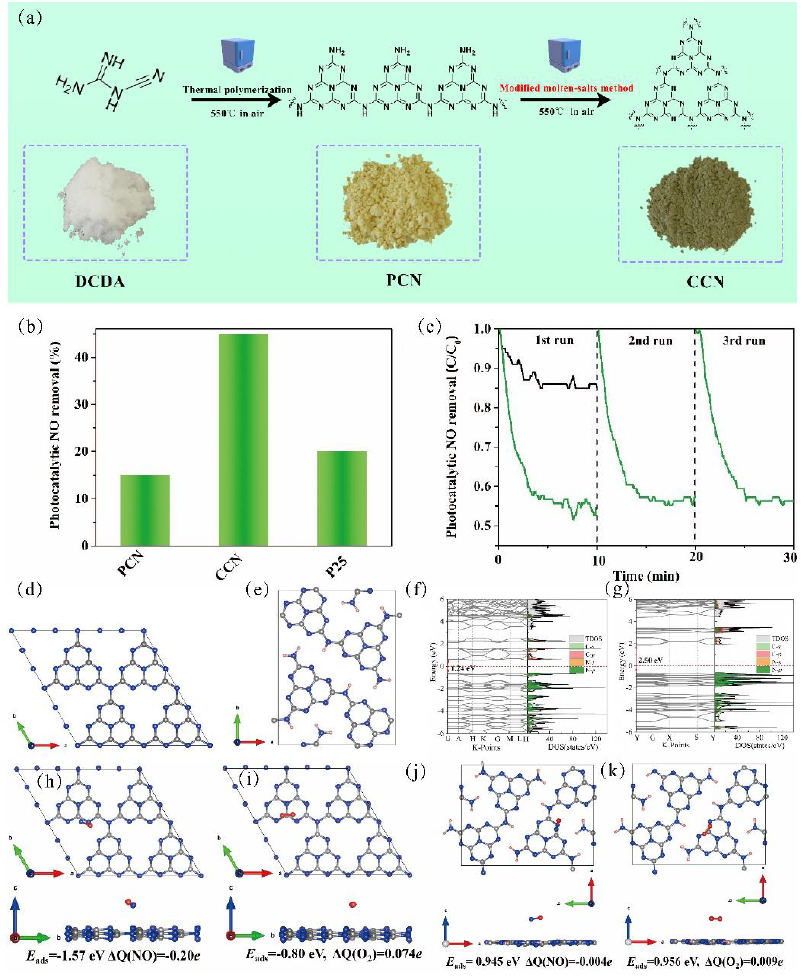
Figure 13. ( a ) Schematic illustration for the preparation of crystalline g − C 3 N 4 using a modified molten salt method under ambient pressure. ( b ) Photocatalytic performance of pristine g − C 3 N 4 , crystalline g − C 3 N 4 and P25 for the removal of NO irradiated under visible light. ( c ) Stability test of crystalline g − C 3 N 4 . ( d – g ) Schematic illustration for crystallinity in g − C 3 N 4 photocatalysts for the enhanced light-harvesting properties. ( h – k ) Schematic illustration for crystallinity in g − C 3 N 4 photocatalysts for the enhanced adsorption behavior [116]. Copyright 2021, Elsevier.